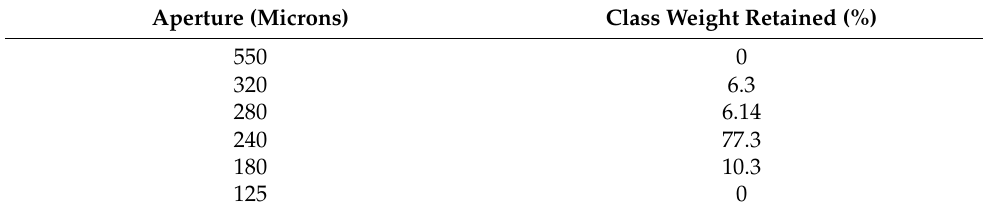
Table 2. Particle size distribution of microencapsulated CALb-alginate.